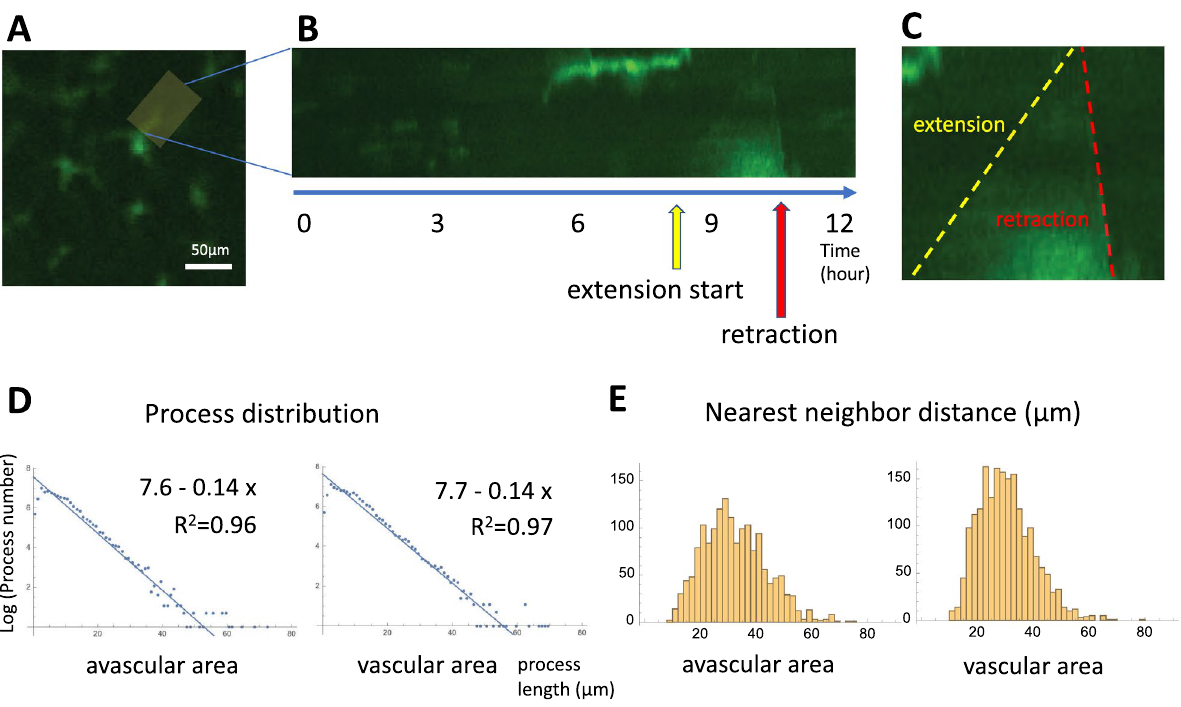
Figure 5. Dynamics of microglia process formation. ( A ) We obtained the kymograph of microglia process dynamics in the yellow area for 12 h. Scale bar: 50 µm. ( B ) Microglia extended the process slowly and retracted quickly. ( C ) The process extension inclination is the yellow line, and the retraction is the red line. ( D ) The histogram of process distribution. ( E ) The histogram of NND.